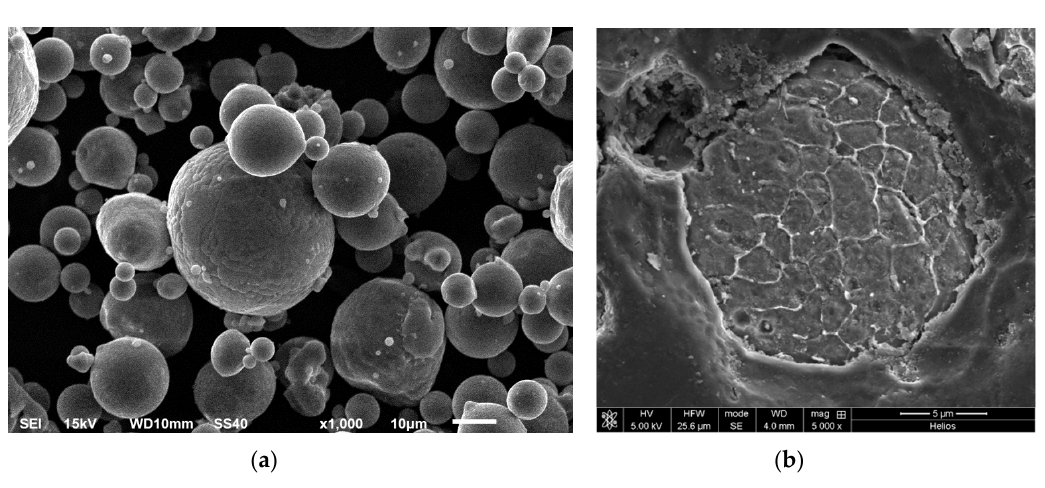
Figure 1. Scanning electron microscopy (SEM) micrograph of AA 6005A powder in the as received condition, ( a ) dispersion in size of the powder particles ( b ) cross section of one particle showing the internal substructure.